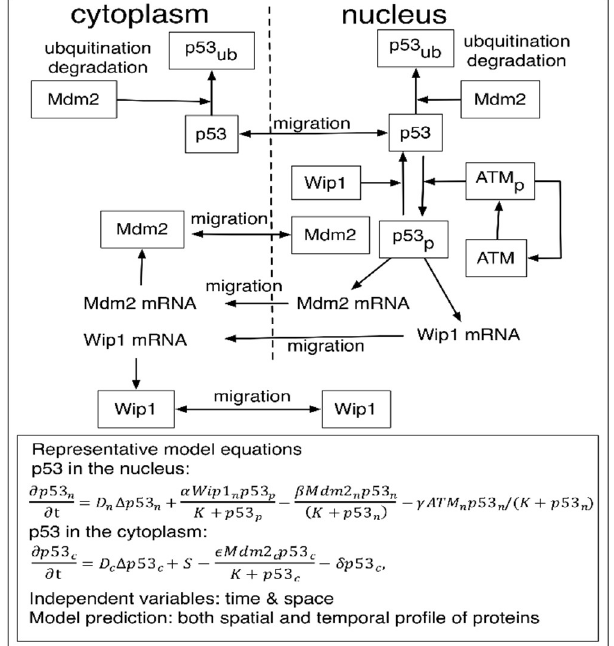
Figure 2. A PDE model developed by Elias et al. [42] Figure and equations adapted with permission from [42] Copyright 2014 Physical Biology. The model diagram explains p53, Mdm2, Wip1 dynamics both in the nucleus and the cytoplasm. Representative partial differential equations that described change of p53 with respect to time in the nucleus as well as in the cytoplasm.